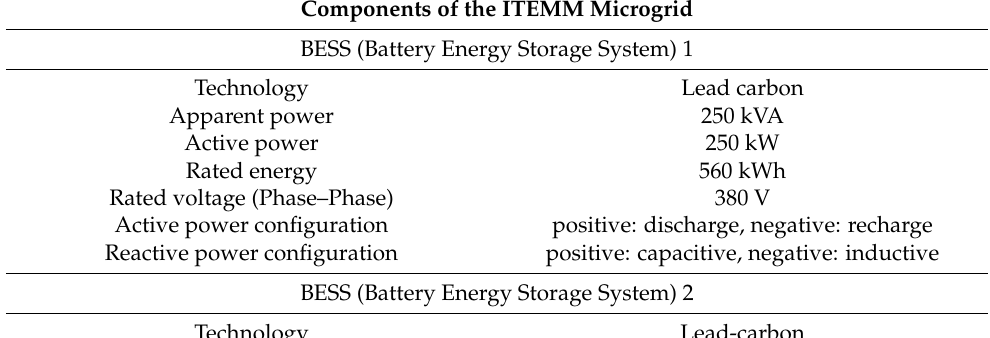
Table 5. Simplified technical specifications of the components used in the ITEMM